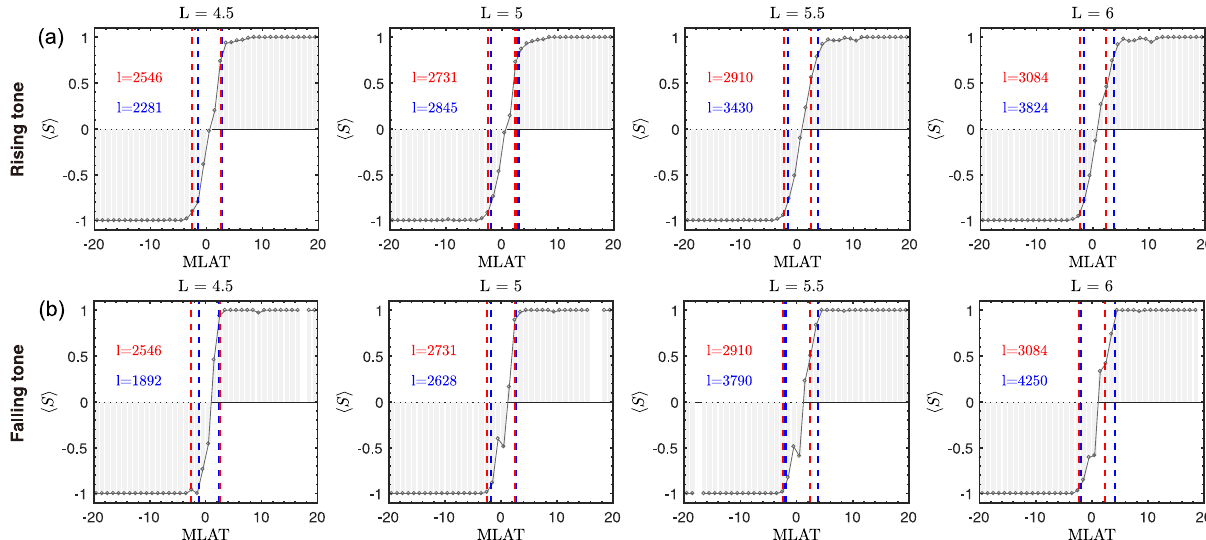
Figure 5. Comparison of the source-region size between theoretical (red) and observational results (blue) at different L shell’s. The top four panels are for rising-tone chorus, the lower four for falling-tone chorus (for L = 4 . 5 of falling tone, the blue line on the right is overlapping with the red line). Observational estimates of the source-region size are marked by blue dashed lines and theoretical estimates by the red dashed lines. Source-region sizes in kilometers are shown in the corresponding